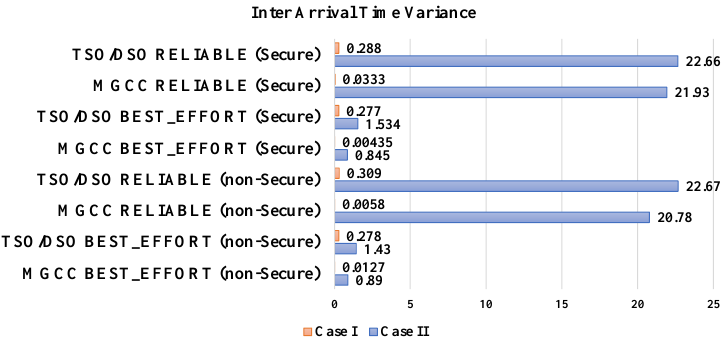
Figure 5. MG as FR-support case studies performance. The simulation results are demonstrated according to the QoS’s communication specification of the MG as the utility grid FR provision utilization, including latency, reliability, and